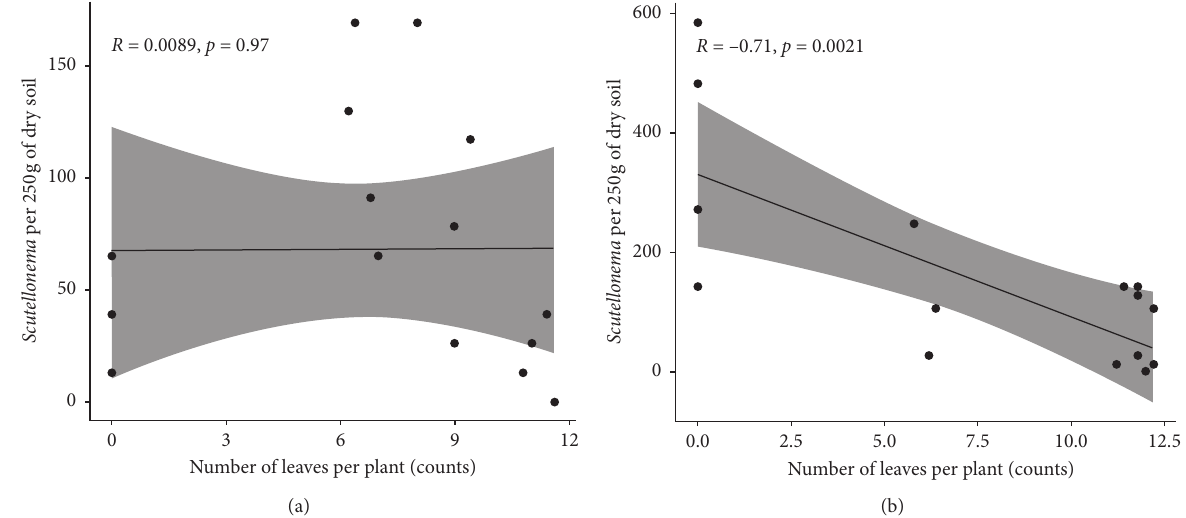
Figure 3: Correlation between number of leaves per plant and Scutellonema abundance during 2018 (a) and 2019 (b) in MPWN treatments. The association for 2018 revealed a very weak positive nonsignificant association ( R � 0.01, p � 0 . 97), whereas for 2019 it was negative ( R �− 0.71, p ≤ 0 .